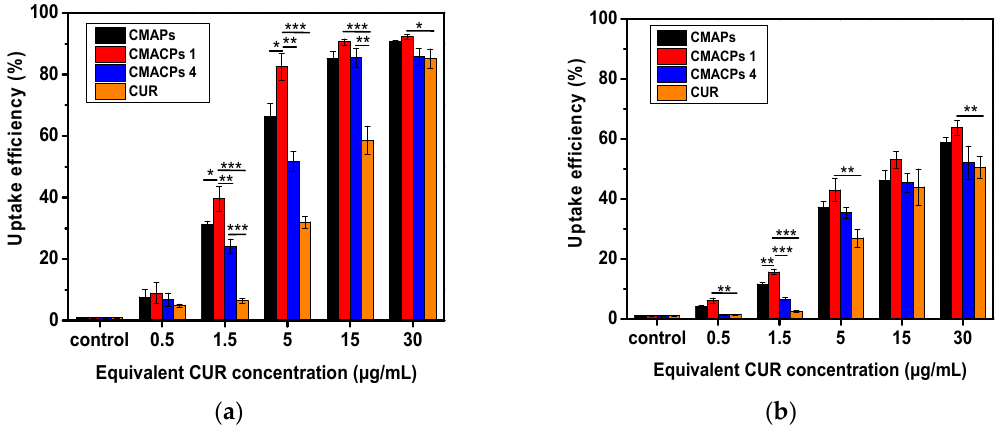
Figure 6. Cellular uptake analysis of CUR in MDA-MB-231 cells ( a ) and HDF cells ( b ) after incubation with CMAPs, CMACPs 1 and 4 and free CUR for 24 h. The CUR uptake was analysed by flow cytometry. The dosages of CUR in particles were equivalent to the amounts of free CUR used. CMACPs 1 and 4 represent CMACPs that possess 1 and 4 layers of polymers coated on MNPs respectively. The results are shown in mean ± SD, n = 3. The statistical significance is expressed as *** p < 0.001, ** p < 0.01, * p <0.05.